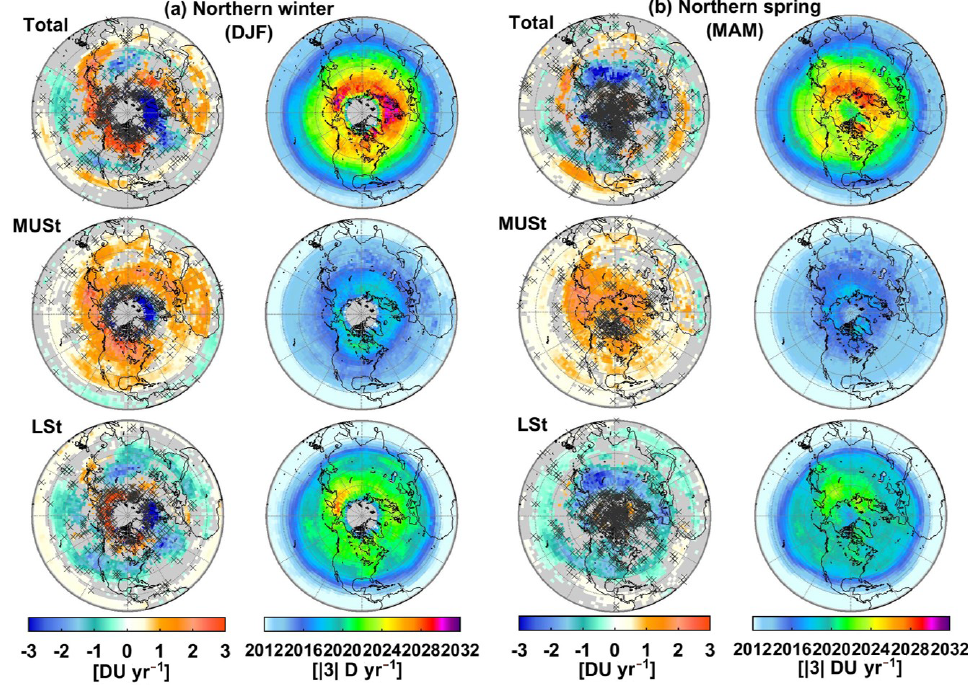
Figure 11. Same as Fig. 10 but (a) for the winter (DJF) and (b) for the spring (MAM) of the Northern